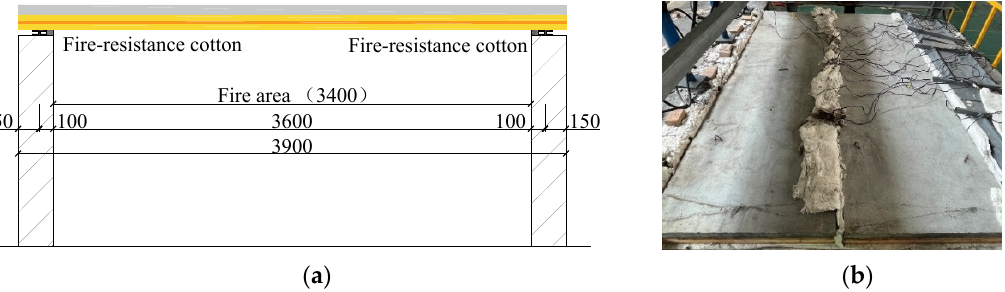
Figure 4. ( a ) Fire test setup (units: mm) and ( b ) the photograph of TCC1 and TCG2 being tested together.